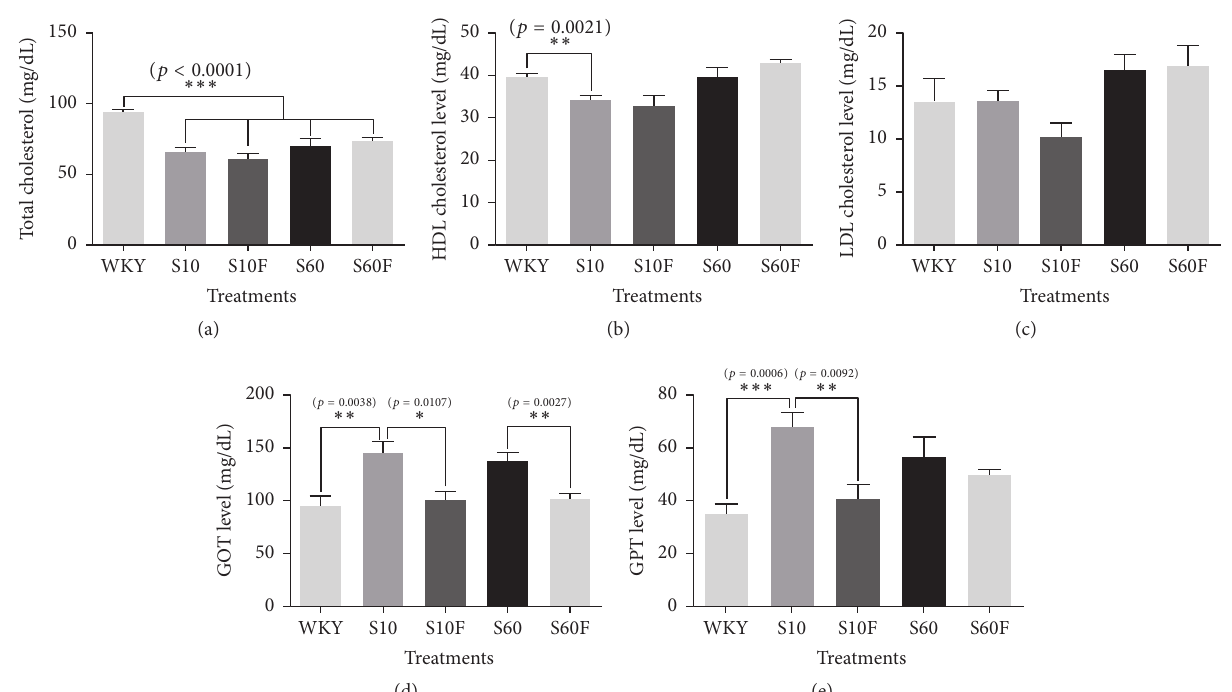
Figure 4: Levels of total cholesterol, high-density lipoprotein cholesterol (HDL cholesterol), low-density lipoprotein cholesterol (LDL cholesterol), glutamic oxaloacetic transaminase (GOT), and glutamic pyruvic transaminase (GPT) in serum of WKY rats and SHRs given high-fat diet and fimasartan. The concentrations of total cholesterol, HDL cholesterol, LDL cholesterol, GOT, and GPT in serum were estimated with TOSHIBA TBA-2000FR according to manufacturer’s instructions. The results are expressed as means ± SEM ( 𝑛 = 6 ). Values were statistically analyzed by unpaired t -test or one-way ANOVA. All experiments were repeated three times. Meaning of indications: WKY means normal control rat given normal diet containing 10% fat, S10 means SHRs given normal diet containing 10% fat, S10F means SHRs given normal diet containing 10% fat plus fimasartan, S60 means SHRs given high-fat diet containing 60% fat, and S60F means SHRs given high-fat diet containing 60% fat plus